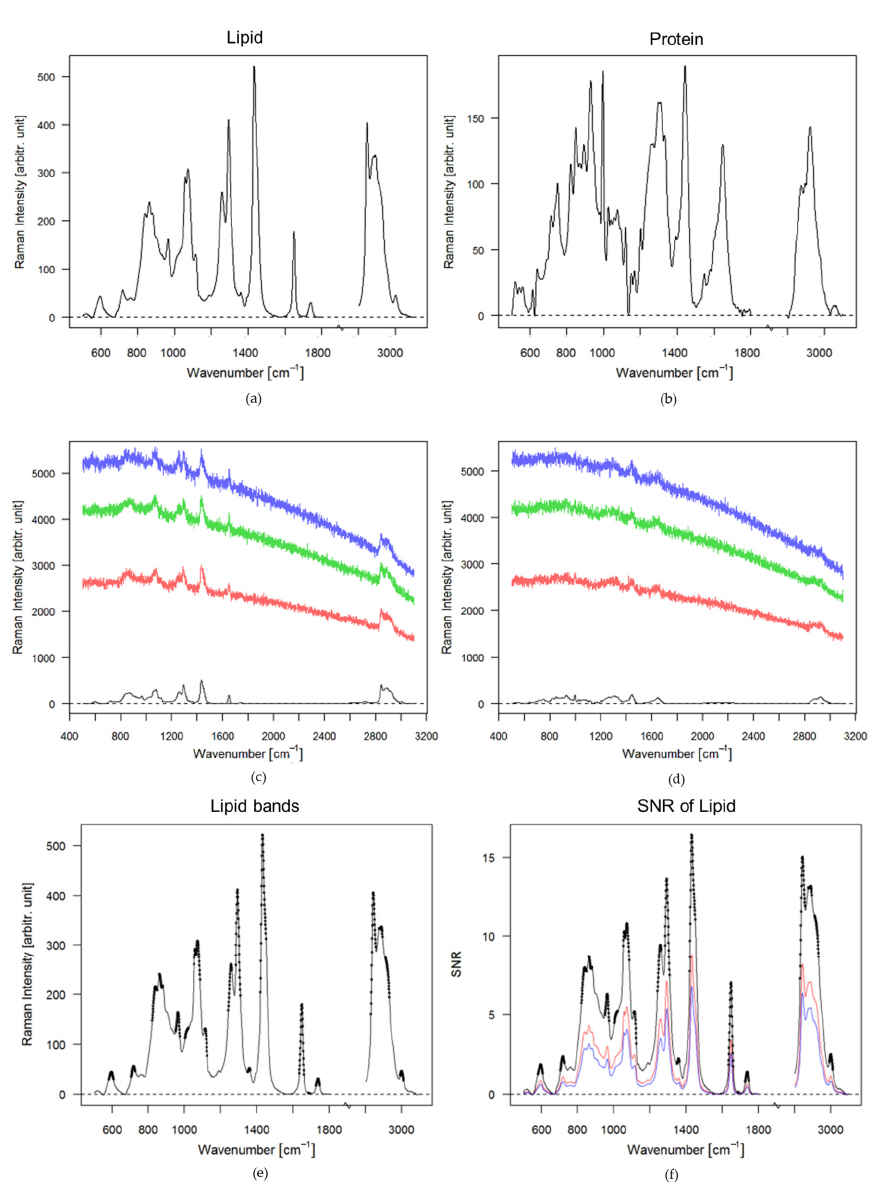
Figure 1. Baseline corrected spectra and spectra with simulated fluorescence backgrounds and shot noise levels: ( a ) Baseline corrected spectrum of lipids; ( b ) Baseline corrected spectrum of proteins; ( c ) Lipid spectra with added fluorescence intensities, i.e., 10 (blue), 8 (green) and 5 (red) times the maximal band of the lipid signal, including corresponding noise levels. The black spectrum is the lipid spectrum without fluorescence; ( d ) Protein spectra with added fluorescence intensities, i.e., 10 (blue), 8 (green) and 5 (red) times the maximal band of the lipid signal, including corresponding noise levels. The black spectrum is the protein spectrum without fluorescence; ( e ) Spectral bands and windows of the measured lipid spectrum, the black points are the maxima and the windows estimated by the Savitzky and Golay function; ( f ) SNR of the lipid spectra with fluorescence, the black spectrum is the SNR of the lipid spectrum, the red spectrum correspond to the SNR of the lipid spectrum with fluorescence 5 times the maximal band of the lipid signal, the blue spectrum is the SNR of the lipid spectrum with fluorescence factor 10 of the lipid